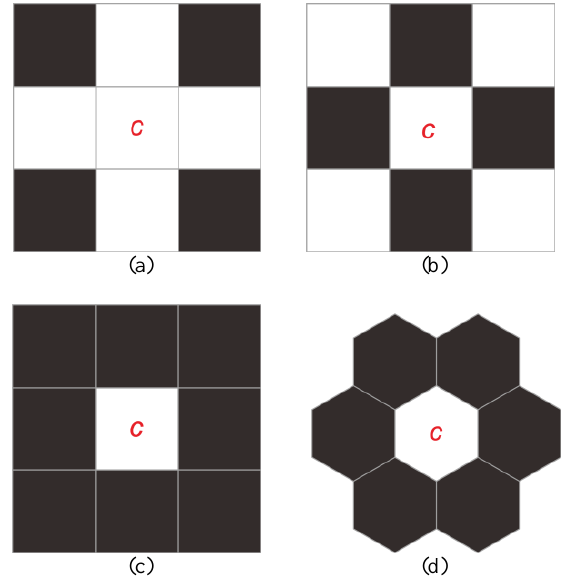
Figure 2. The connectivity between grids in square and hexagonal tessellation models. (a) 4-neighbourhood connectivity defined by corner contact of square tessellation model; (b) 4-neighbourhood connectivity defined by edge contact of square tessellation model. (c) 8-neighbourhood connectivity of square tessellation model; (d) 6-neighbourhood connectivity of hexagonal tessellation model.